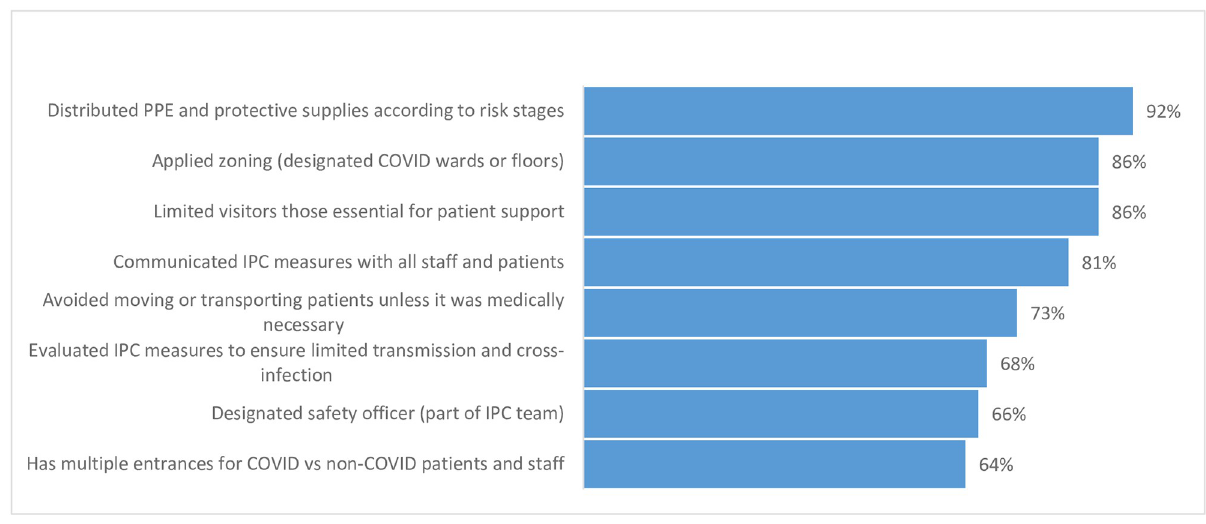
Fig 6. Interventions to limit the nosocomial transmission of COVID-19 in EMR hospitals (N = 139).